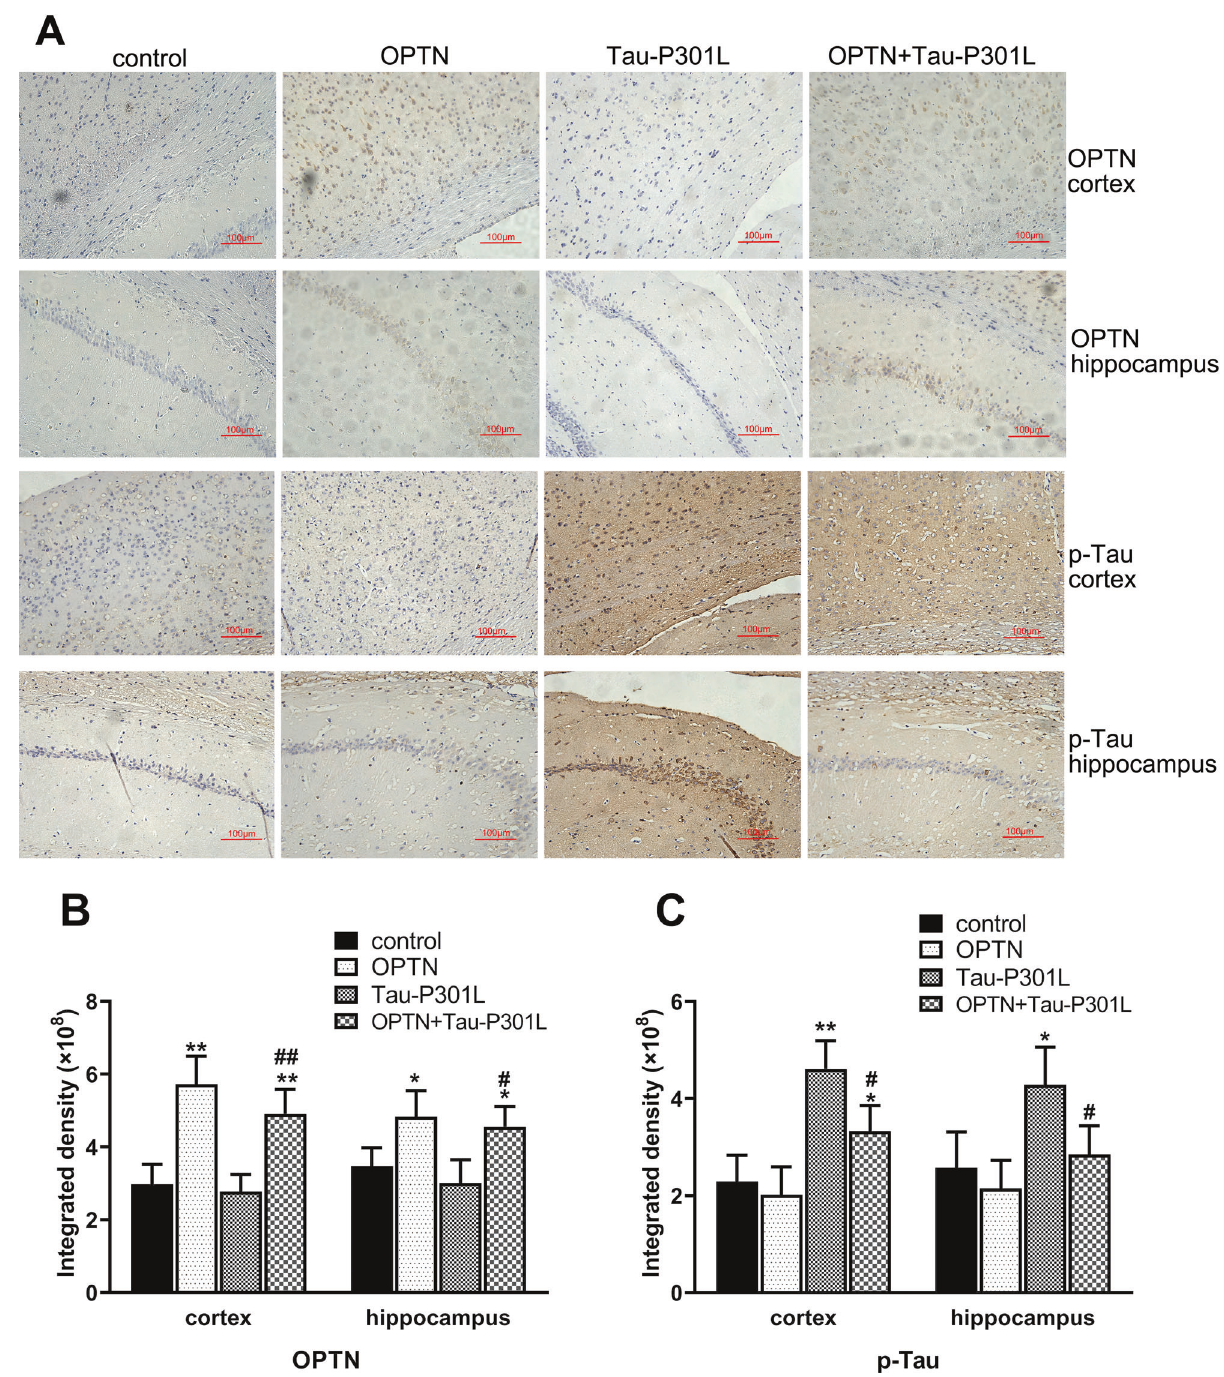
Fig. 7 Immunohistochemical analysis of OPTN and p-Tau in brain tissues of 4-months-old mice infected with AAV in stage P0. A Immunohistochemical sections of OPTN and p-TAU in the cortex and hippocampus of mouse brain tissues (×200). B Histogram of OPTN expression of the cortex and hippocampus. C Histogram of p-Tau expression of the cortex and hippocampus. The data are shown as means ± SD, n = 10. * P < 0.05, ** P < 0.01 compared with control; # P < 0.05, ## P < 0.01 compared with